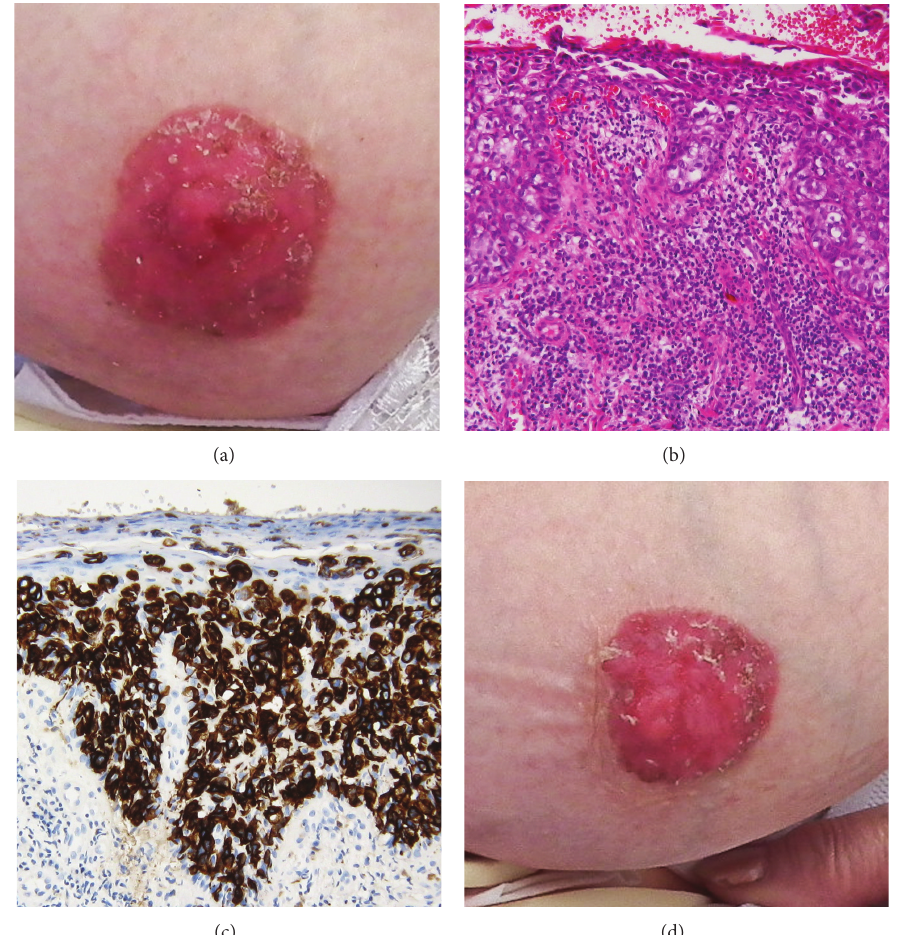
Figure 1: Clinical picture at time of first presentation and histological stains ((a) right breast, (b) cytokeratin 7 stain, (c) HE stain, and (d) left